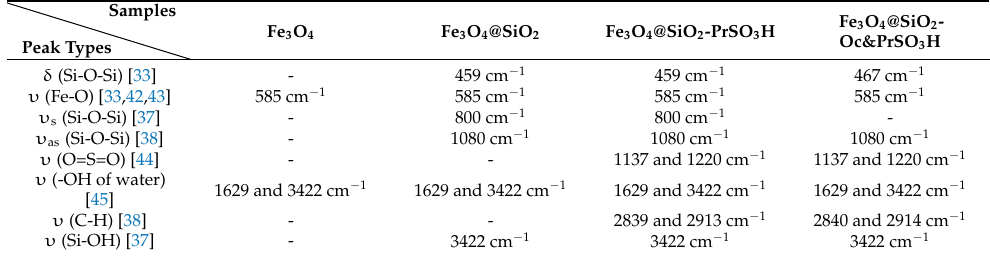
Table 2. The analysis of FT-IR spectra of Fe 3 O 4 , Fe 3 O 4 @SiO 2 , Fe 3 O 4 @SiO 2 -PrSO 3 H and Fe 3 O 4 @SiO 2 - Oc&PrSO 3